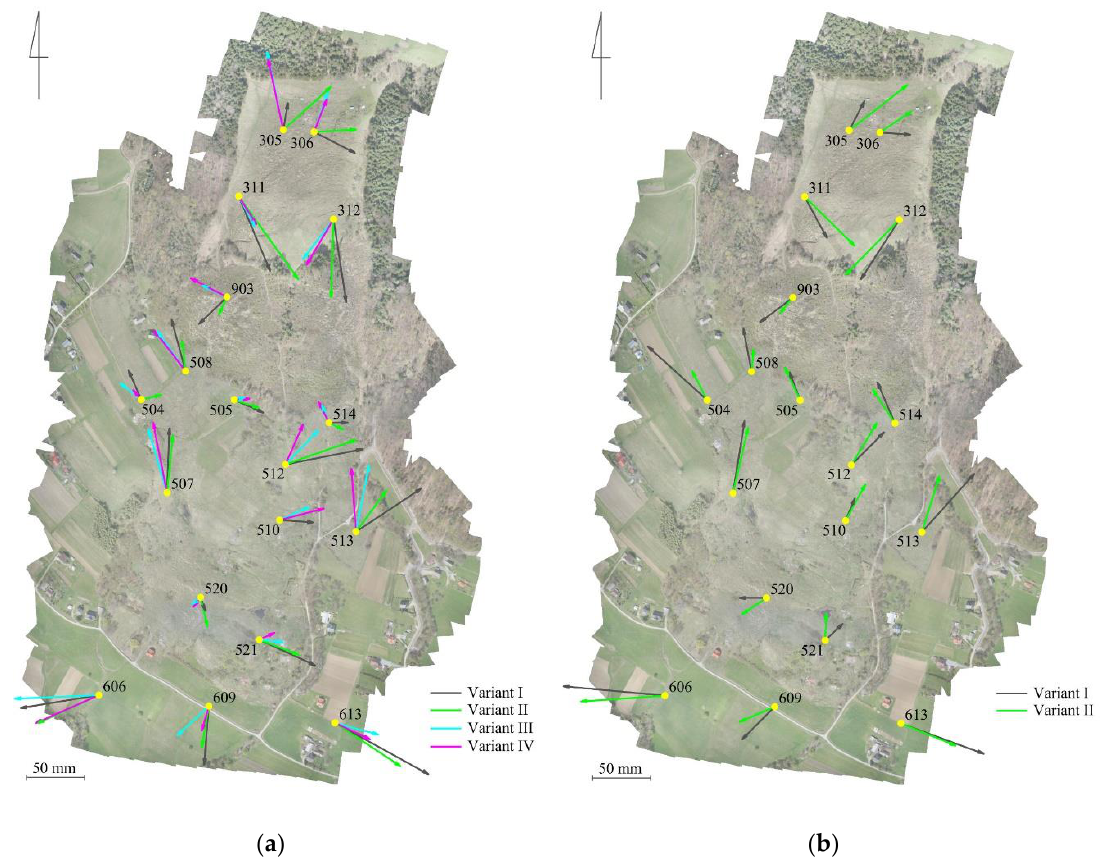
Figure 6. Differences in coordinates for check points compared to an aligned block of photographs: ( a ) check points surveyed using static GNSS; ( b ) check points surveyed using RTK GNSS.